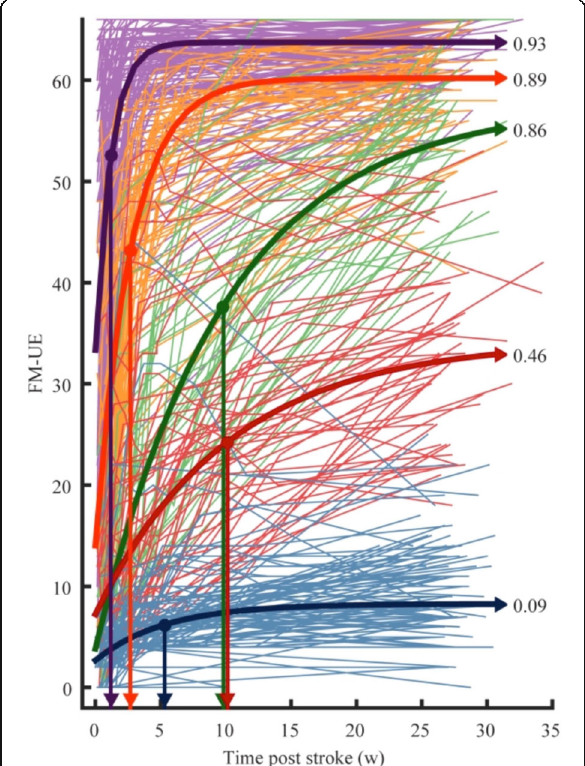
Fig. 2 Motor recovery after stroke in a sample of n = 412 ischemic stroke patients based on the Fugl-Meyer upper extremity (FM-UE) score. Patients with mild initial deficits make on average better recovery than patients with severe deficits. Different colors represent different recovery subgroups based on a longitudinal mixture model. The numbers next to the recovery graphs represent the proportional recovery coefficient r K, which denotes how much of the potential recovery has been achieved based on the FM-UE score. The downward arrows indicate the time constants τ k in weeks, i.e., how fast patients recovered (here: reaching 1-e − 1 = 63.2% of total recovery). Of note, also initially severely affected patients (green curve) can achieve a good outcome with a relatively high recovery coefficient (r k = 0.86) but a longer time constant ( τ k = 9.8 weeks) compared to the other subgroups. From Van der